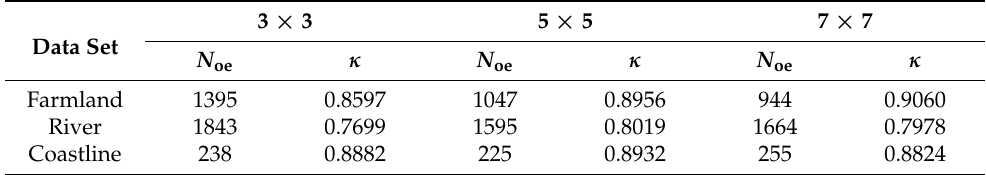
Table 2. Quantitative evaluation of image patch size ω in three data